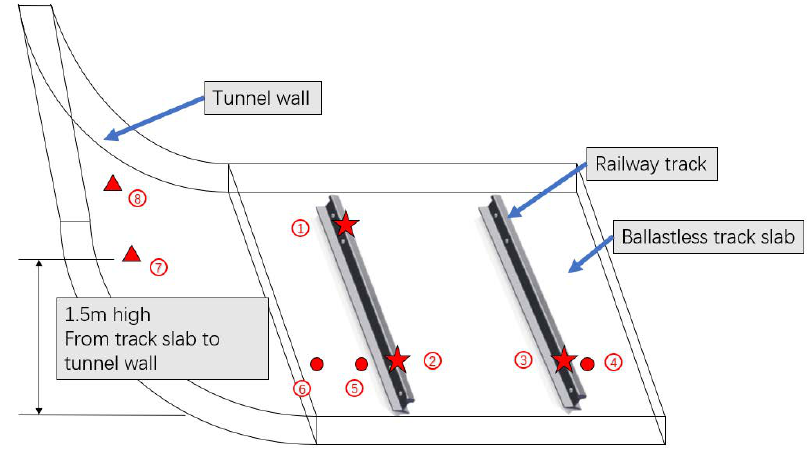
Figure 3. Location of the acceleration sensors. Points 1–3 are on the rail, points 4–6 are on the track slab, and points 7–8 are on the tunnel wall. The circle is the point on the track slab, the star is the point on the railway track, and the triangle is the point on the tunnel wall.